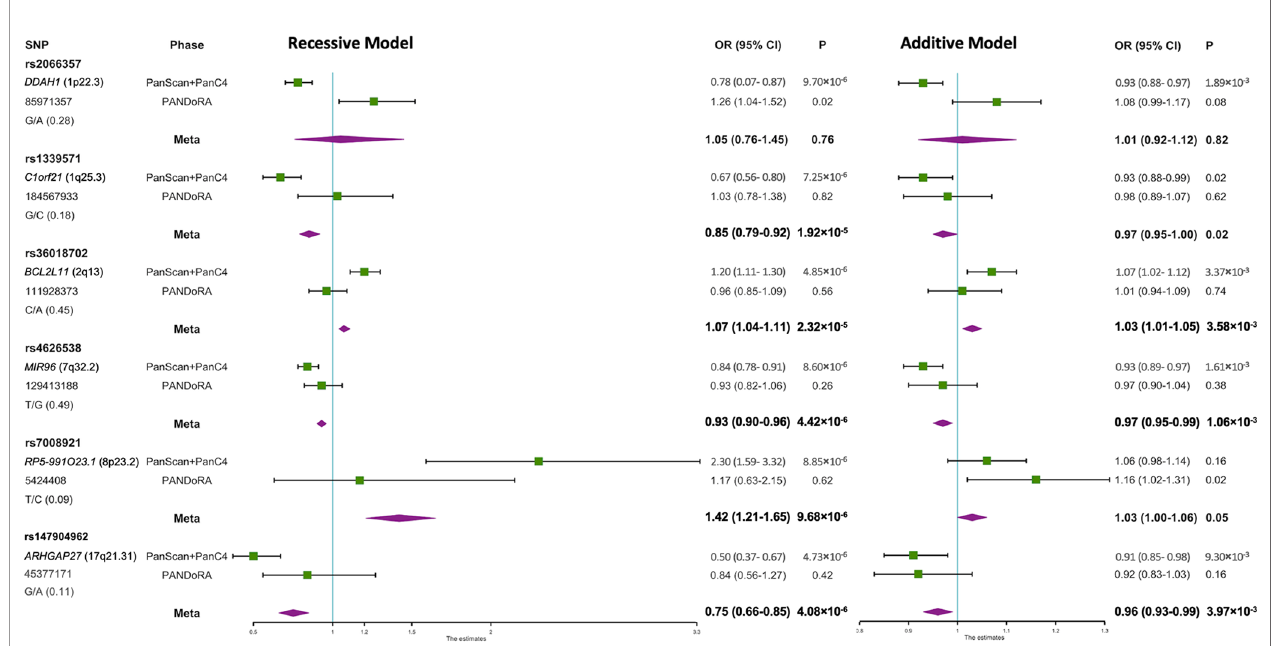
FIGURE 1 | Forest plot of the associations of the 6 SNPs with PDAC risk under recessive and additive genetic models. A forest plot for the 6 SNPs and risk of PDAC is shown by two genetic models using data from discovery and replication analyses combined. Population speci fi c odds ratios (OR) and 95% con fi dence intervals (CI) are denoted by green boxes and black lines. The combined OR estimates are represented by purple diamonds, where diamond width corresponds to 95% CI bounds. The position information (hg38) and minor allele frequency (MAF) for each SNP are shown on the